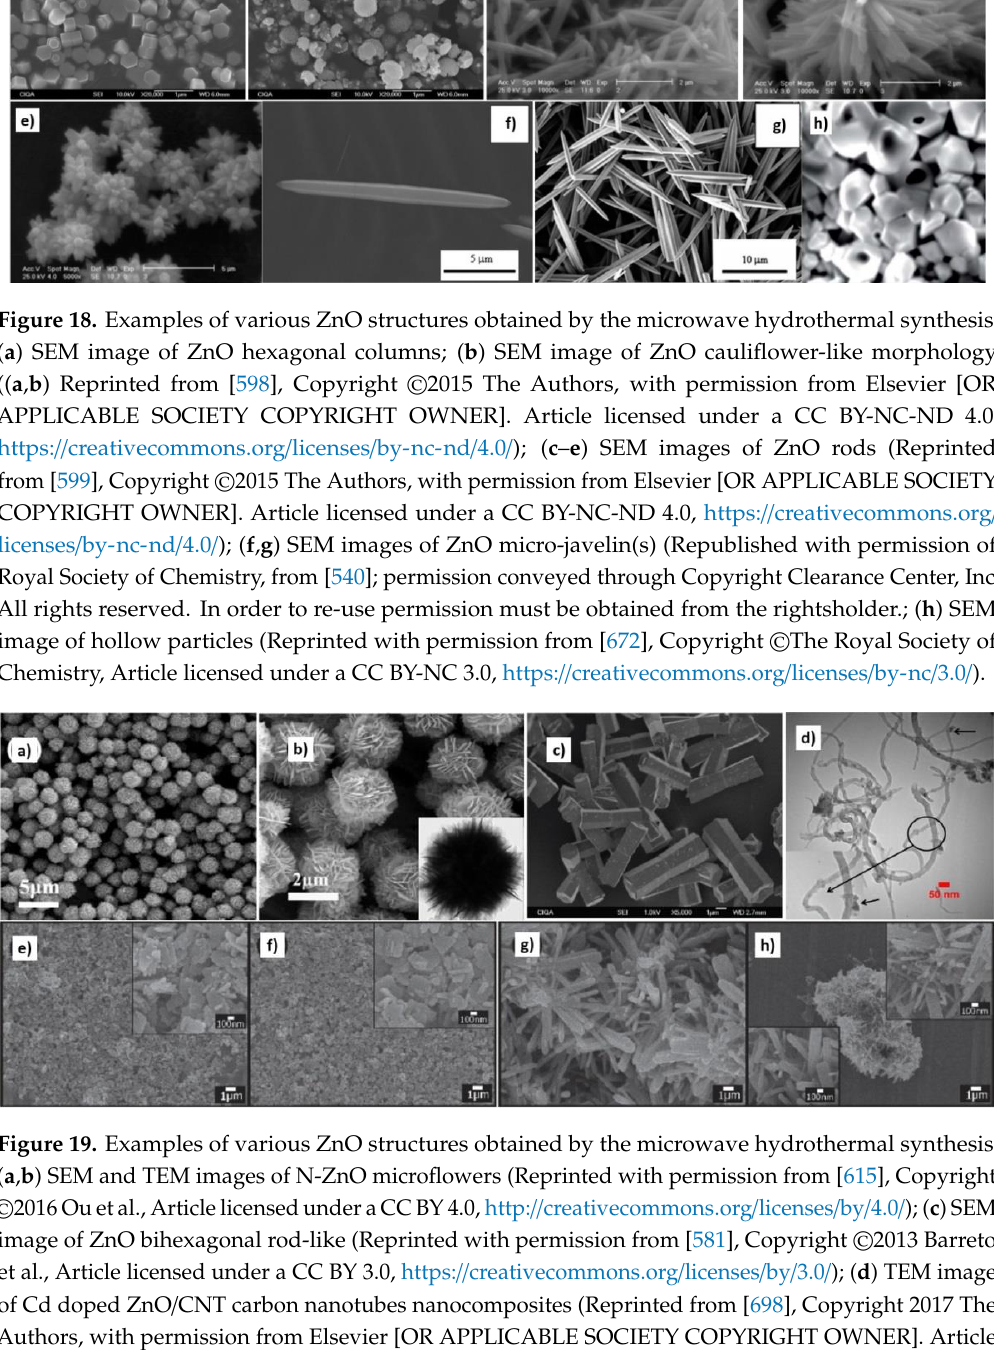
21 of 150 Figure 17. Examples of various ZnO structures obtained by the microwave hydrothermal synthesis: ( a , b ) Scanning electron microscopy (SEM) image and Transmission electron microscopy (TEM) image of Fe doped ZnO nanostars, respectively (Reprinted with permission from [679], Copyright © 2015 Kwong et al., Article licensed under a CC BY 3.0, https://creativecommons.org/licenses/by/3.0/); ( c , d ) SEM images of ZnO nanoplates grown on office papers (Reprinted with permission from [607], Copyright